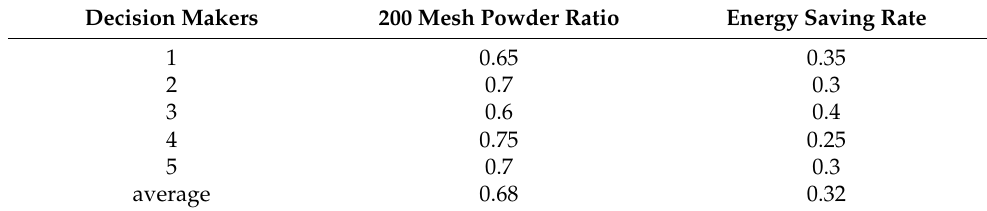
Table 2. Two-hundred mesh powder ratio index